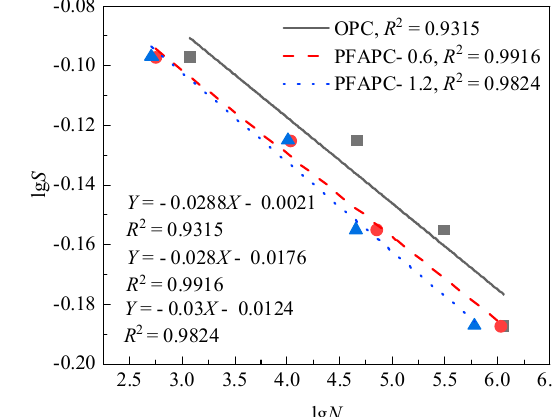
Figure 9. P-S-N curve when survival probability P = 95% is considered under two-parameter Weibull distribution.